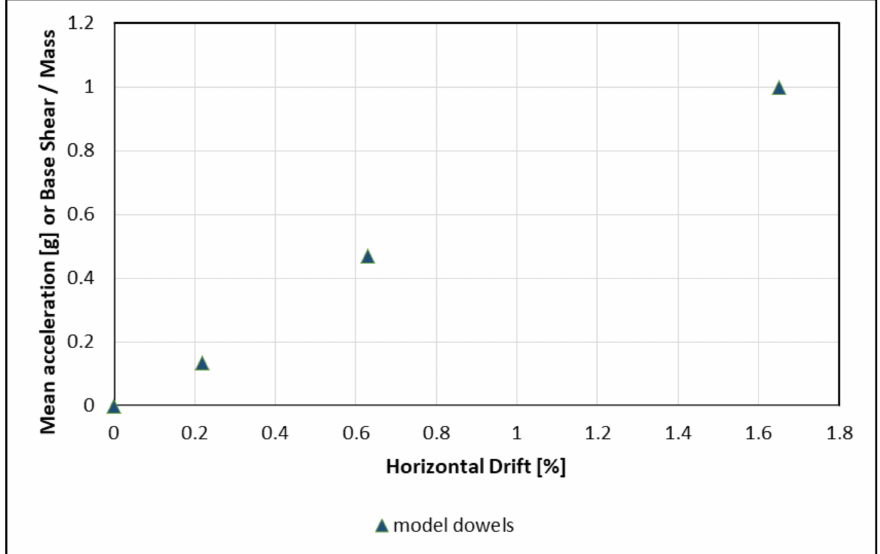
Figure 7. Mean slab acceleration (or base shear/mass) versus horizontal drift diagram for the model 3DOW with additional steel